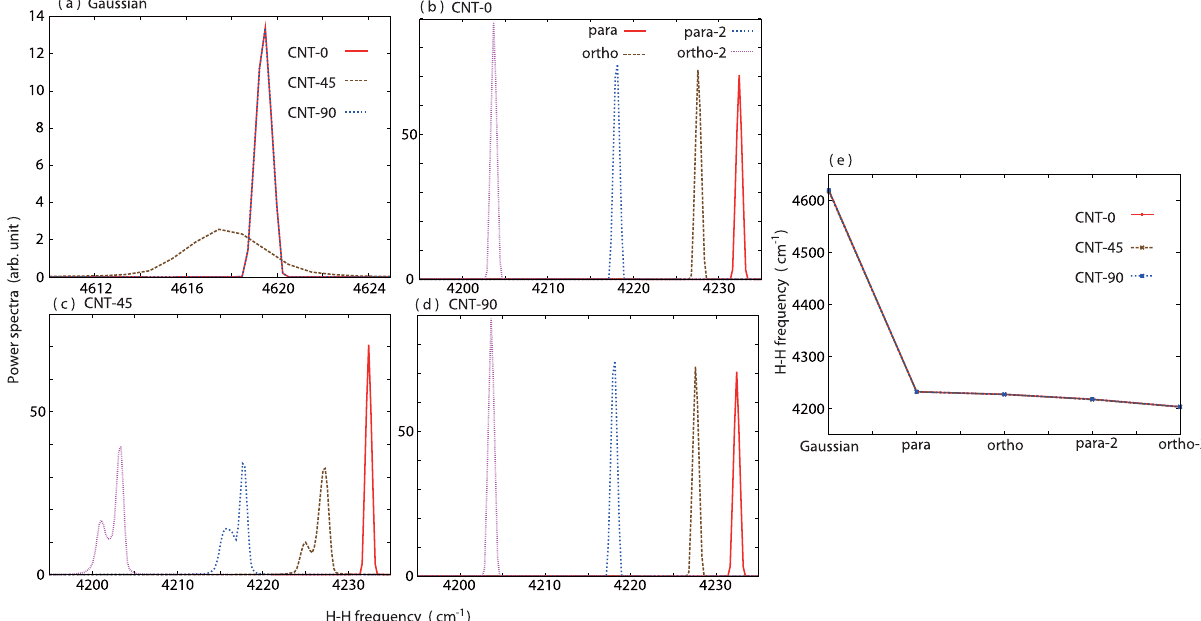
Fig. 5 H-H vibrational dynamics during the collision dynamics with CNT(15,0). Vibrational power spectra of the H-H bond length R rel ( t ) of Gaussian ( a ) for the initial collision angles 0 degree (CNT-0), 45 degree (CNT-45), and 90 degree (CNT-90). Vibrational power spectra of the H-H bond length R rel ( t ) of the shell-type species for CNT-0 ( b ), CNT-45 ( c ), and CNT-90 ( d ). e H-H vibrational frequencies estimated from the peak frequencies of the vibrational power spectra shown in ( a – d